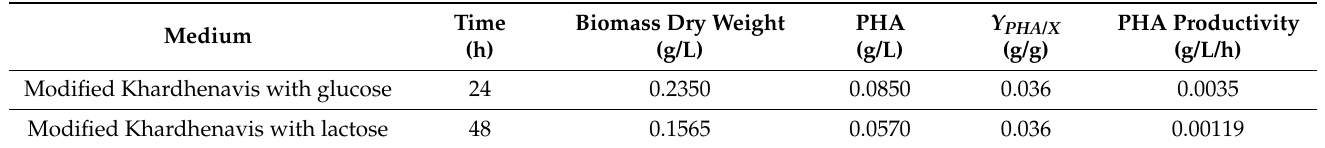
Table 3. Main parameters of PHA production in flask test with L. mesenteroides. The relative standard error of the data reported is 5% (obtained from triplicated experiments).